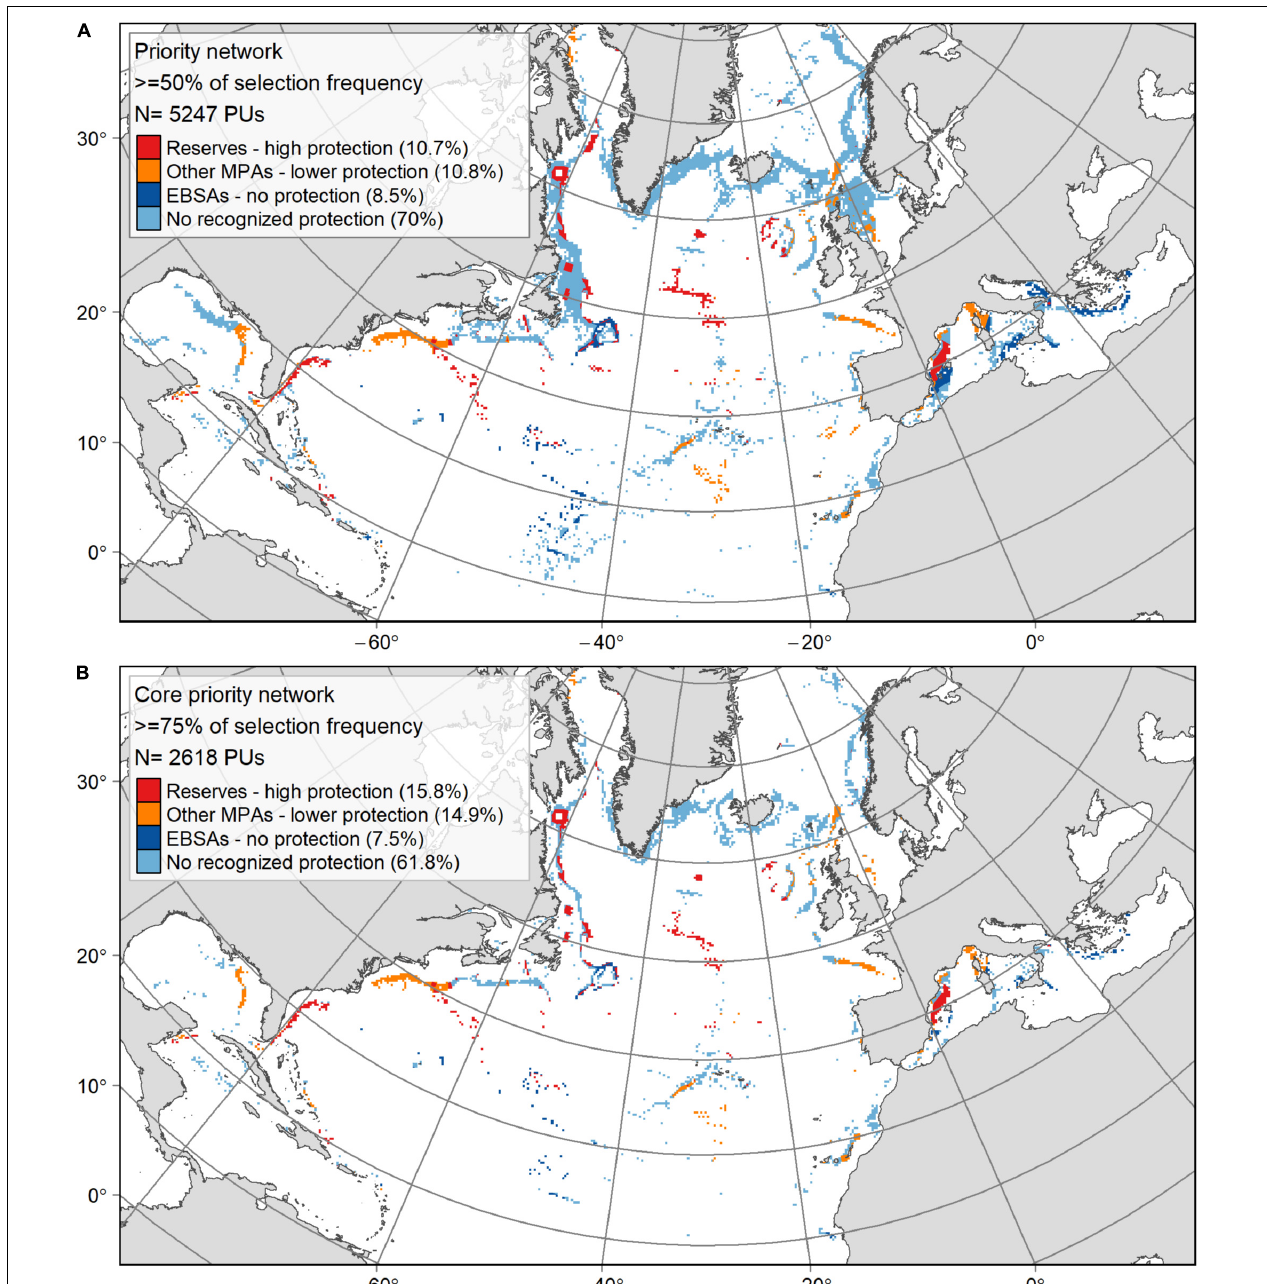
FIGURE 8 | Maps showing the priority conservation networks selected in the “Management” scenario solutions, where PUs occurred in at least 50% (A) or 75% (B) of the selection frequency. The colour categories differentiate between current spatial management and designation categories together with their contribution (% of the priority network): (1) restrictive marine reserves and RFMOs fishing closures providing a high protection; (2) other MPAs with lower protection level; (3) CBD EBSAs with no legal protection; and (4) areas that have no protection of any kind or a protection that is not recognised as an MPA by the World Database of Protected Areas or as an EBSA by the